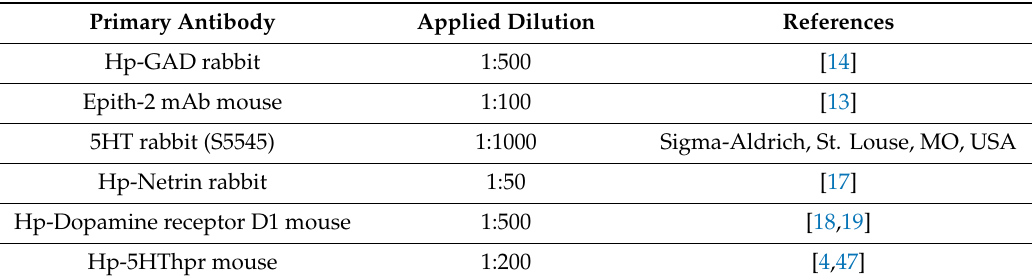
Table 1. List of antibodies used in this study and their